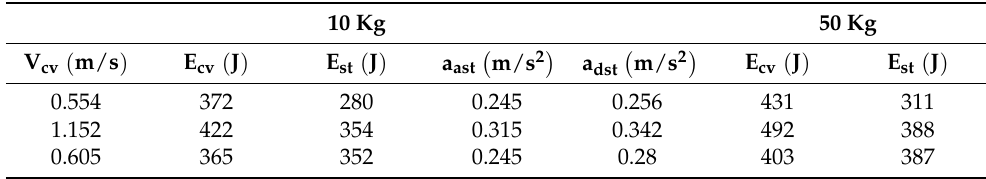
Table 6. Effect of load